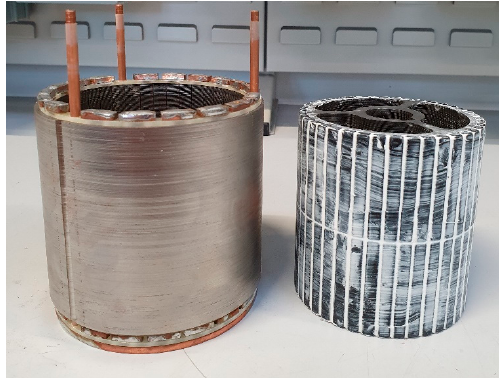
Figure 19. Picture of stator and rotor.